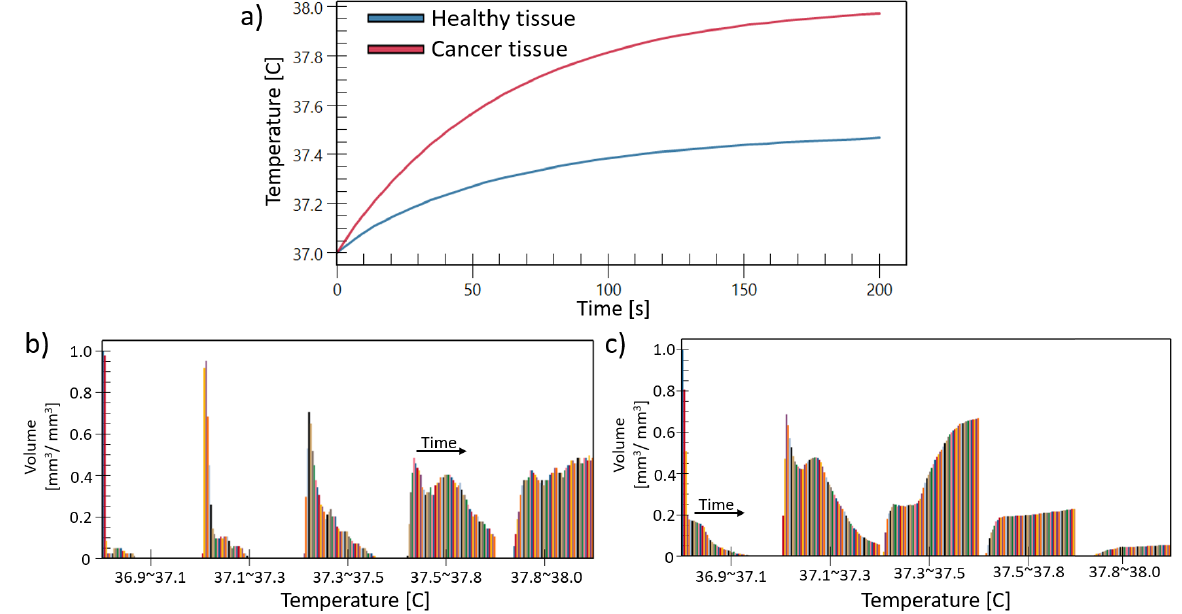
Figure 10. Temperature comparison as a function of time between healthy tissue (without RF heating focus) and cancer tissue (with RF heating focus) ( a ). The histogram of the temperature change on time in terms of normalized volume, for the case of ( b ) the cancer tissue, ( c ) the healthy tissue.